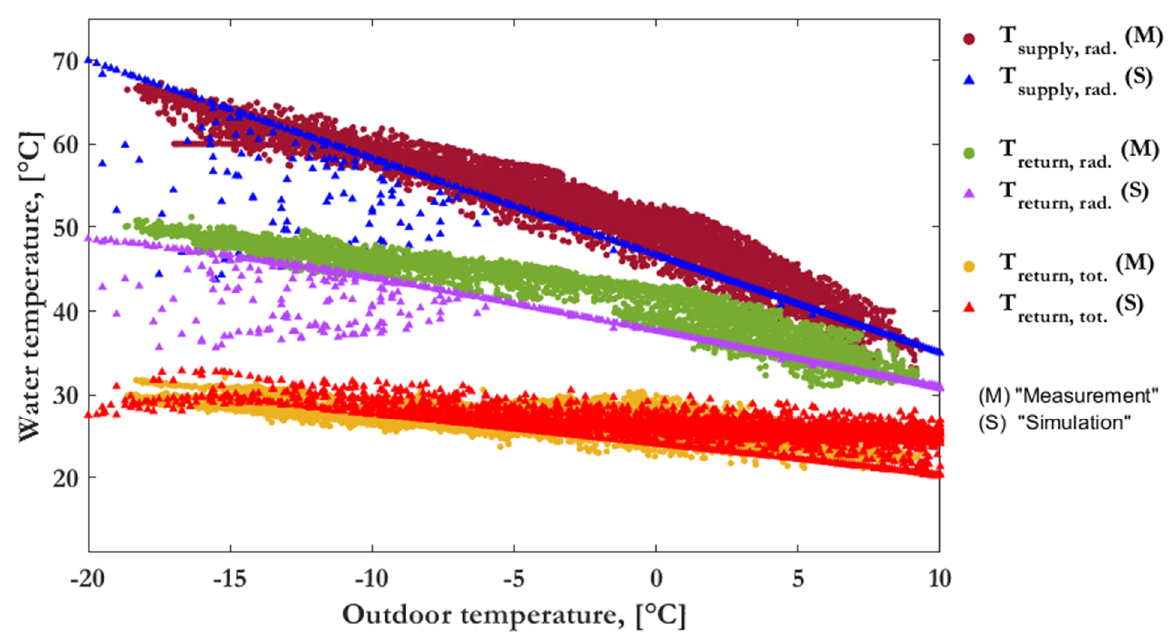
Figure 3. Comparison between measurements and simulations for hydronic temperature flow .